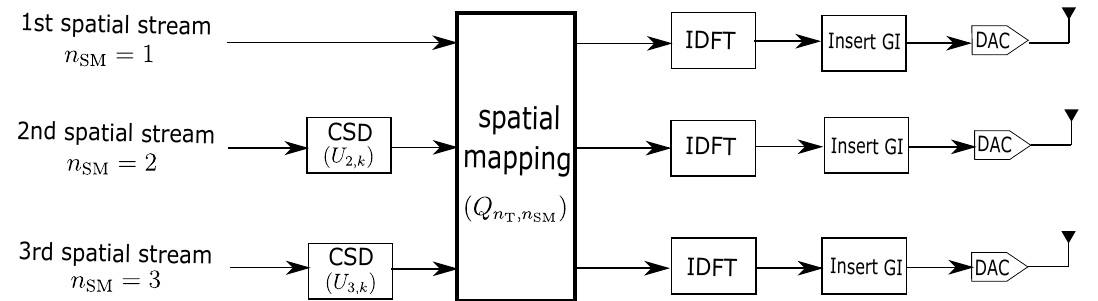
Figure 2. Partial Wi-Fi transmitter block diagram with 3 spatial streams being mapped by spatial mapping (SM) and cyclic shift diversity (CSD) according to IEEE 802.11n